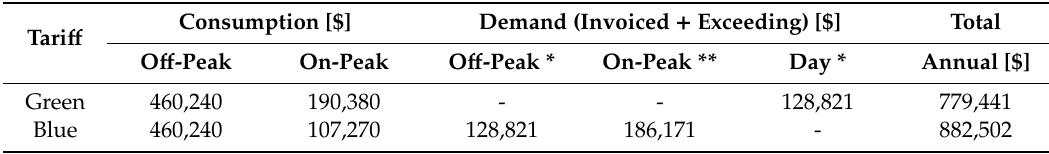
Table 9. Main results for Scenario 5.